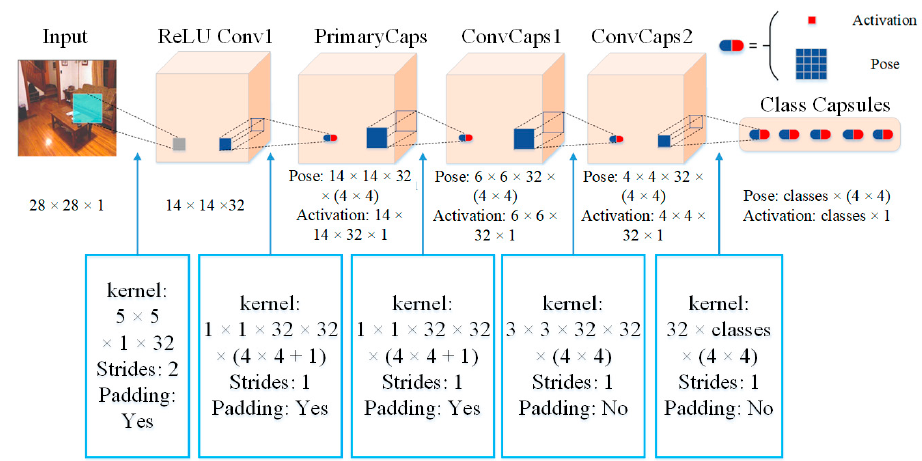
Figure 2. Architecture of the matrix capsule network.